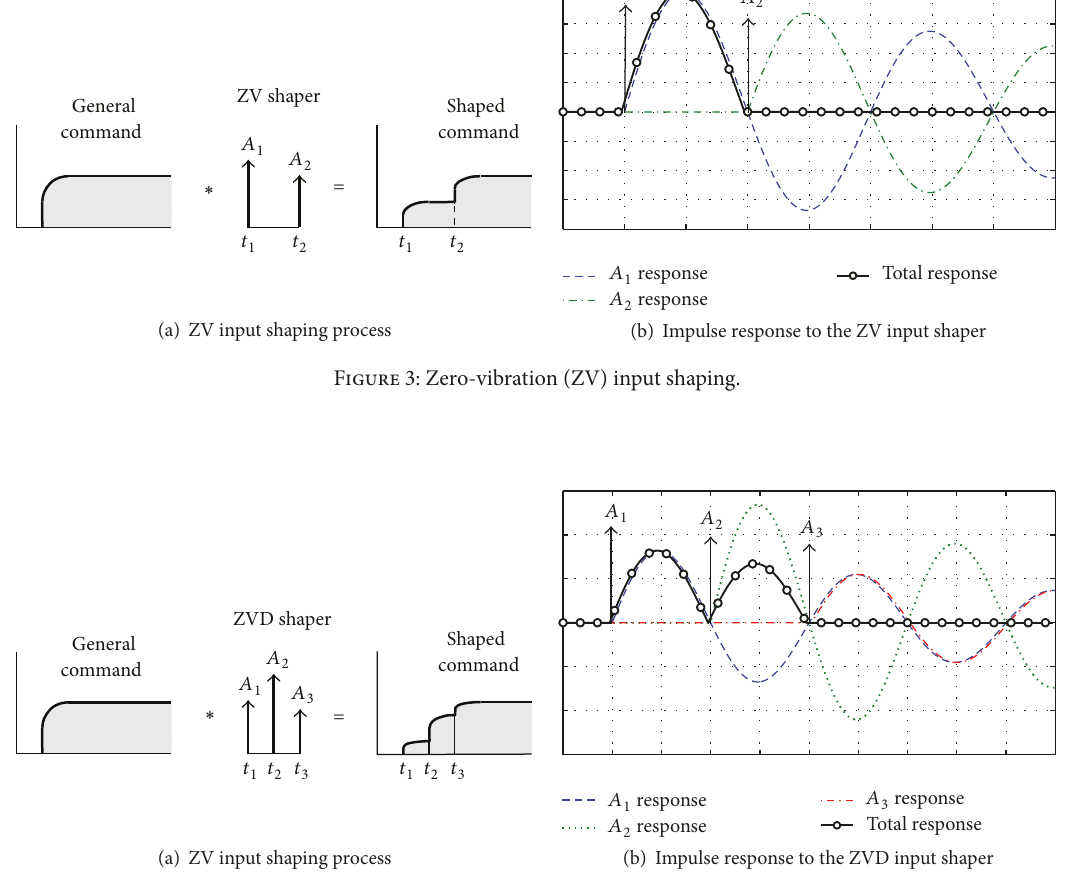
Figure 4: Zero-vibration-derivative (ZVD) input